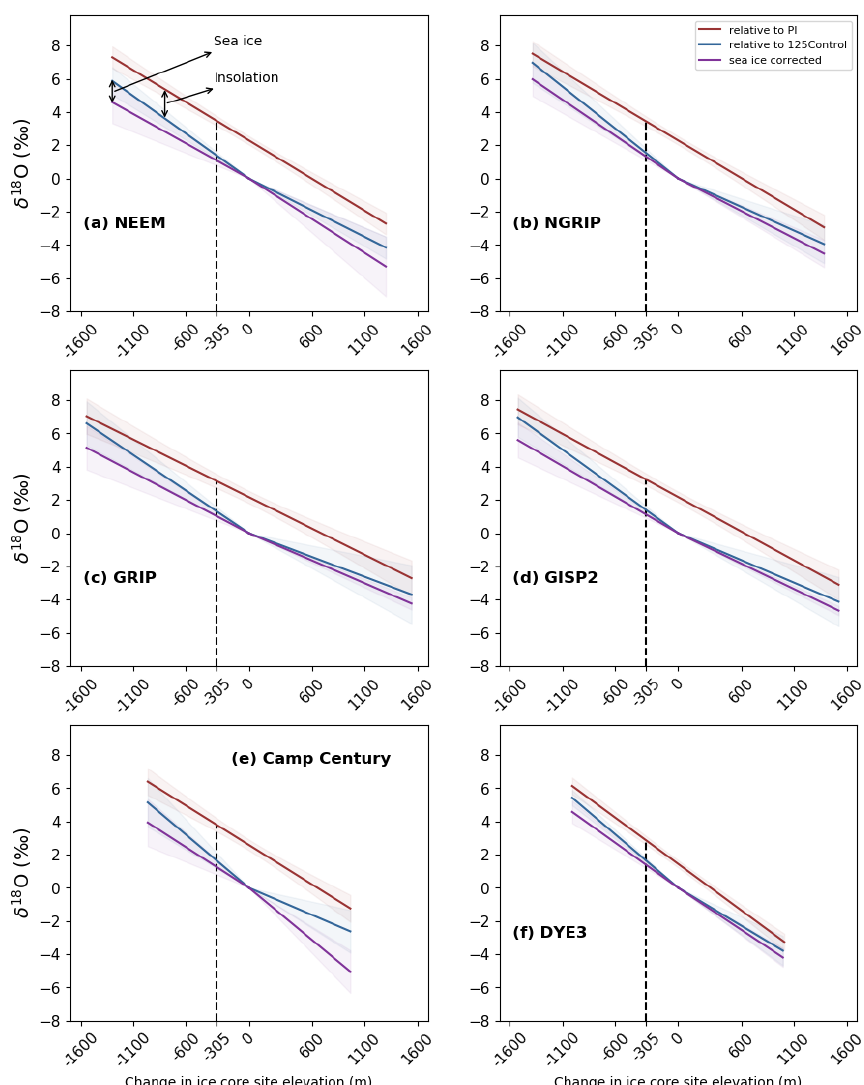
Figure 9. δ 18 O p anomalies as a function of the ice core site elevation change (m) relative to PI (red) and 125Control (blue). Also shown are sea-ice-corrected δ 18 O p anomalies relative to 125Control (purple). Ice core sites shown: (a) NEEM, (b) NGRIP, (c) GRIP, (d) GISP2, (e) Camp Century, (f) DYE3. Solid lines signify best fit curves and shade envelopes represent ± 3 SD on the best fit lines. Arrows indicate the influence of insolation and sea ice changes on δ 18 O changes. In addition, the purple line (sea-ice-corrected δ 18 O p anomalies) represents the influence of GIS changes and associated atmospheric circulation changes on δ 18 O